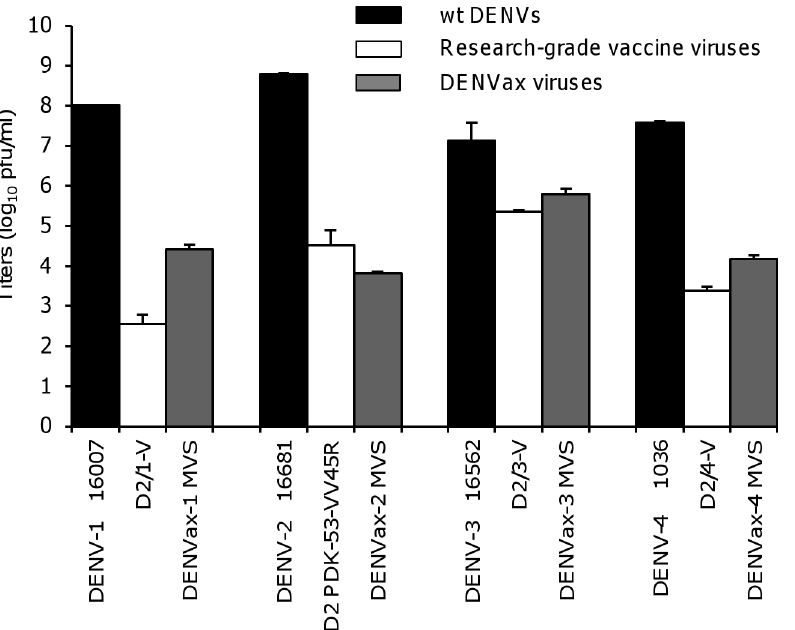
Figure 3. Restricted growth of DENVax MVS in C6/36 cells. Mean titers 6 SD (error bars) of the viruses replicated in C6/36 cells 6 days pi. The wt DENVs and previously published research-grade vaccine candidate viruses were included for comparison.